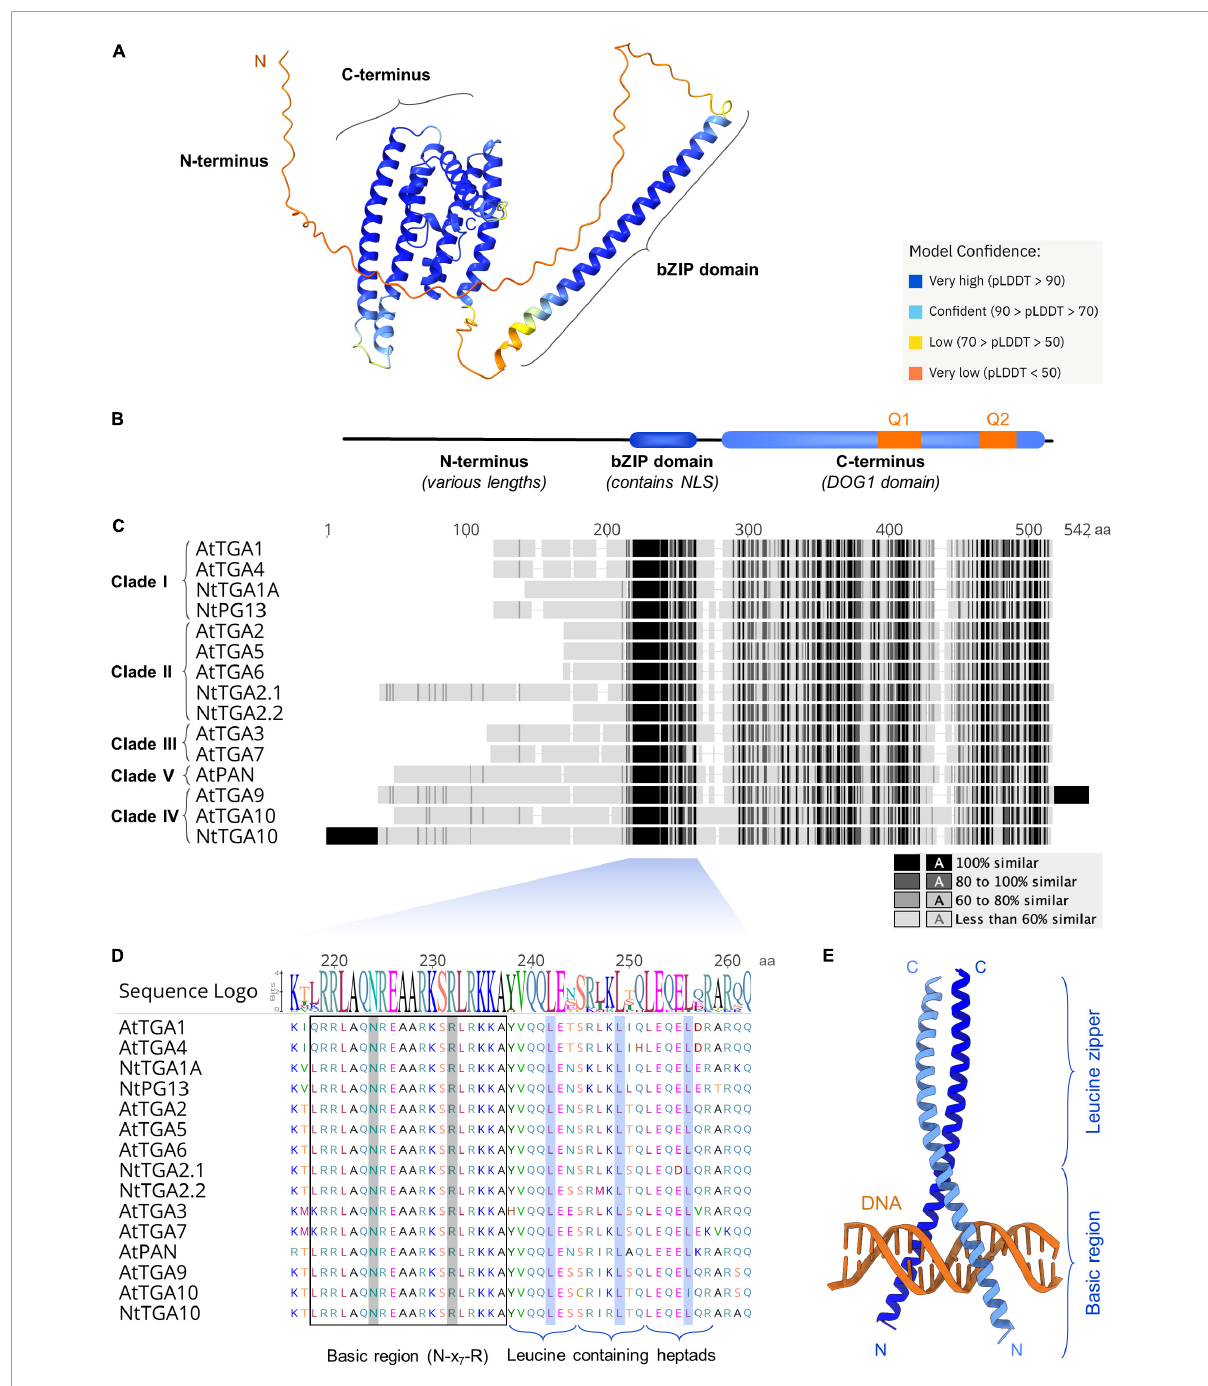
FIGURE2 Among the three main TGA protein parts, the bZIP domain is the most highly conserved. (A) The AlphaFold generated 3D model of AtTGA1 (Jumper et al., 2021; Varadi et al., 2022) (pLDDT, AlphaFold per-residue confidence score) and (B) a schematic representation of TGA domain organization, showing the flexible N-terminus, the bZIP domain and the C-terminus, encompassing a putative Delay of Germination 1 (DOG1) domain. The nuclear localization signal (NLS) and glutamine rich regions Q1 and Q2 are indicated. (C) Multiple sequence alignment of ten Arabidopsis and five tobacco TGAs, with segments of high similarity or identity colored darkest and lowest similarity lightest, shows the bZIP domain retains the highest sequence identity throughout the whole protein sequence. In cases where sequence segments at N-terminal or C-terminal ends are not aligned to any of the other sequences, they are considered identical and are colored black. (D) A closer examination of the bZIP domain shows few variations in the basic region, while the three zipper heptads, with conserved leucine residue positions marked, show higher variability. The alignment and sequence logo were prepared and visualized with Geneious Prime 2020 (Kearse et al., 2012), using default parameters. (E) Structural model of the human FosB-JunD bZIP dimer in complex with DNA (5VPE entry in RCSB PDB) (Yin et al., 2017). The models in (A,E) were visualized in UCSF ChimeraX (Pettersen et al.,